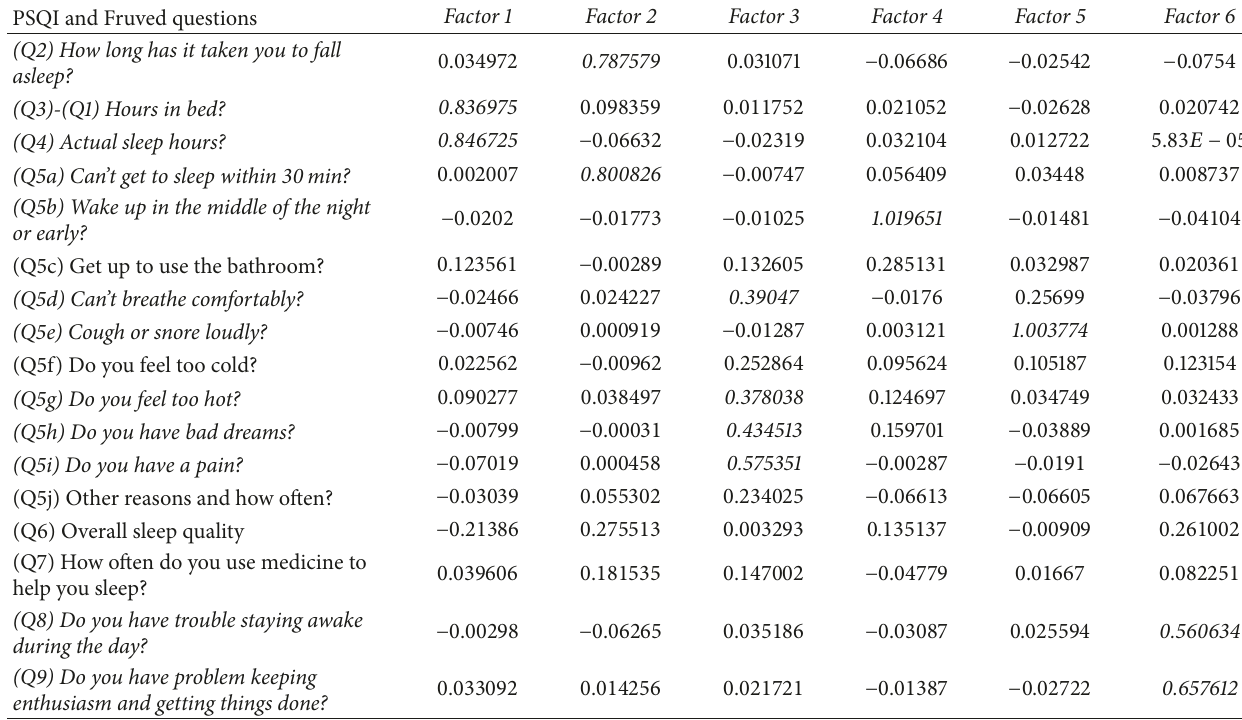
Table 4: Rotated factor loading in factor analysis Using Promax